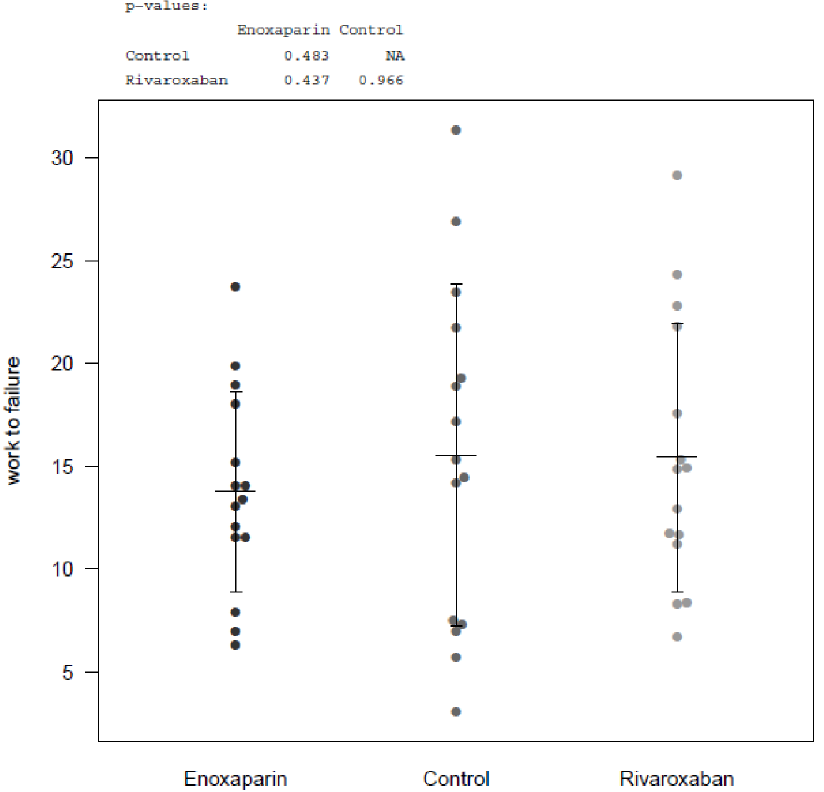
Fig 4. Results Biomechanical Testing, work to failure. Dot-plots of work to failure (Nmm) for controls, Rivaroxaban and Enoxaparin; experimental sides (fracture). No sign. differences between controls and